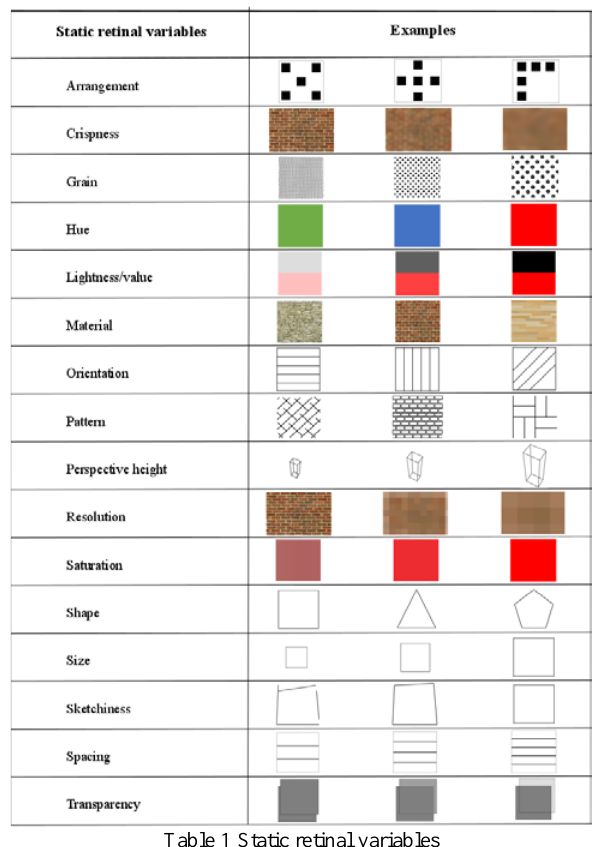
Table 1 Static retinal variables